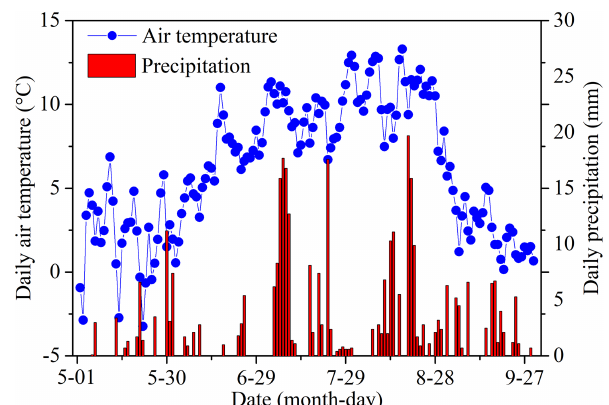
Figure 3. Daily average air temperature and precipitation of the study site in